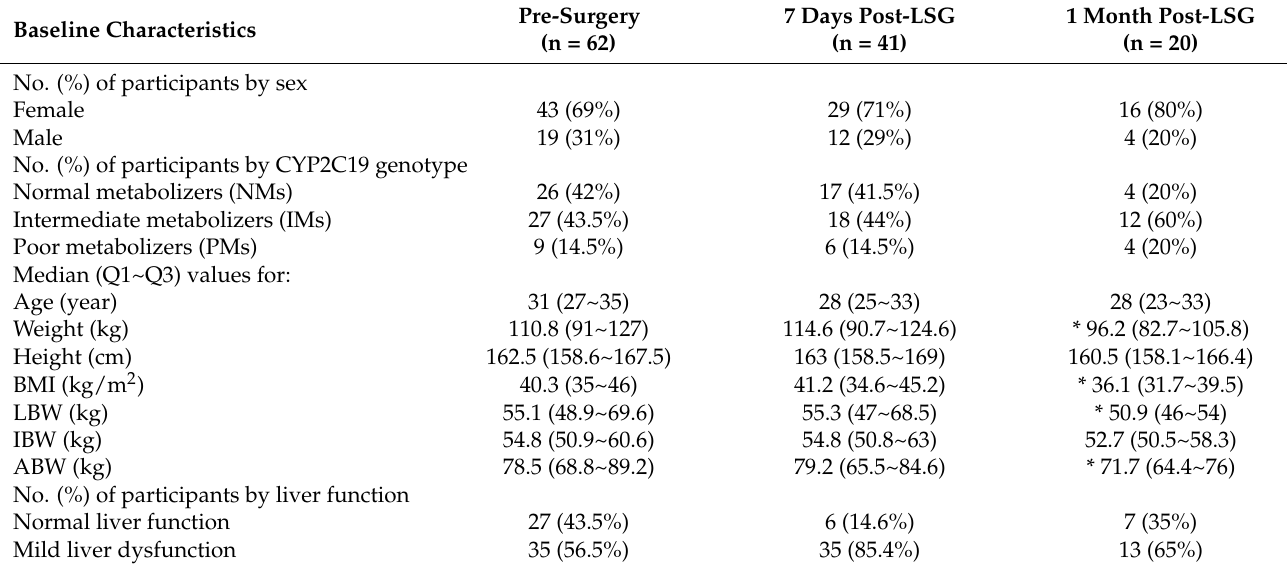
Table 1. Demographic and clinical characteristics of study